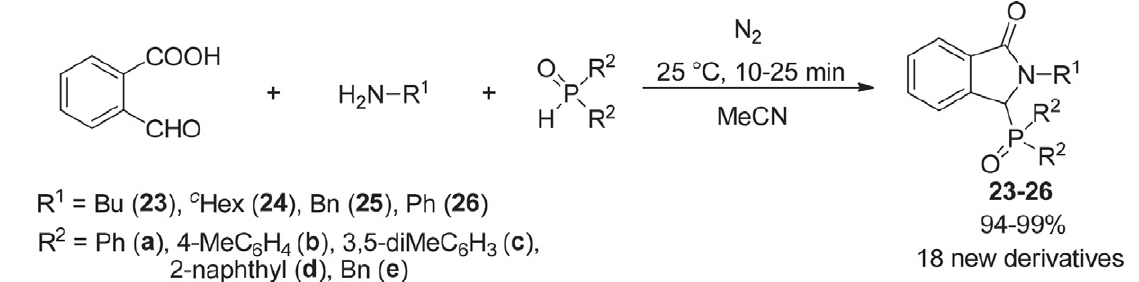
Scheme 2. The reaction of FBA , primary amines and secondary phosphine